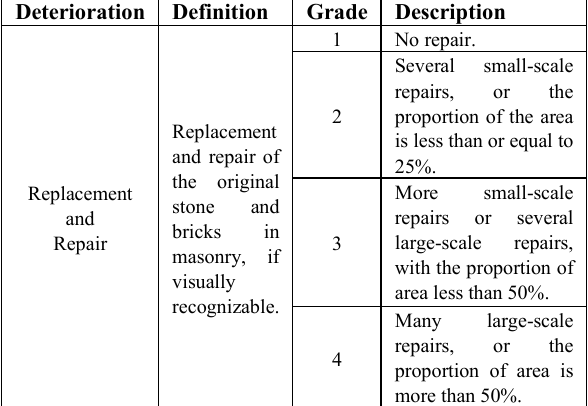
Table 3. Definition and grading standards of replacement and repair.